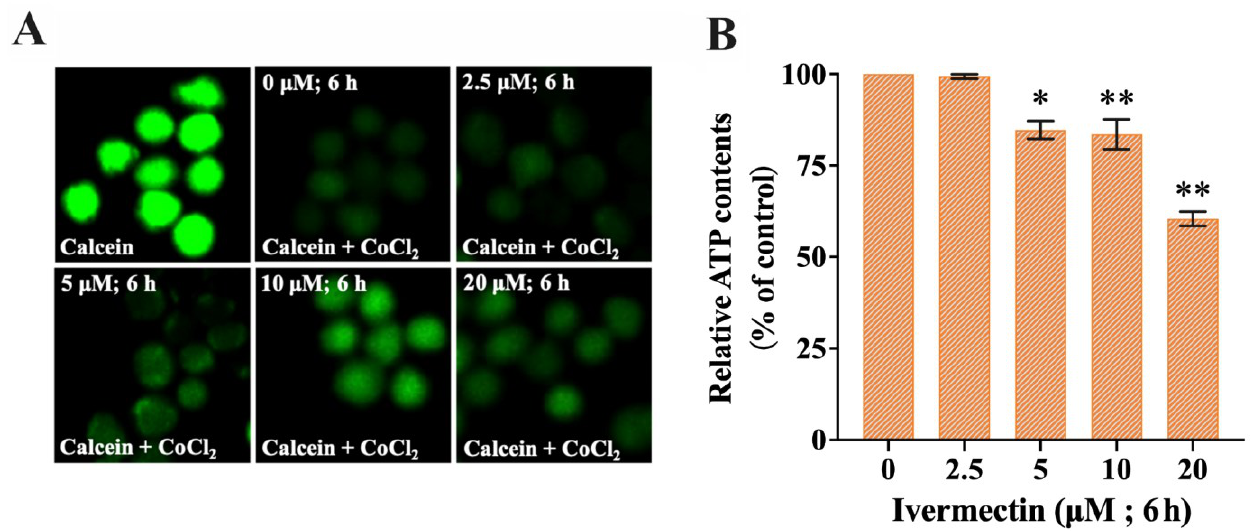
Figure 4. The effect of IVM on ATP content in RAW264.7 cells. ( A ) After IVM treatment of cells for 6 h, the mPTP opening was detected by co-loading with calcein-AM and CoCl 2 (200 × ). ( B ) ATP content was measured after IVM treatment of cells for 6 h. Data were expressed as means ± SD (standard deviation) of three separate sets of independent experiments. * p < 0.05, ** p < 0.01, and indicate significant differences from the control.